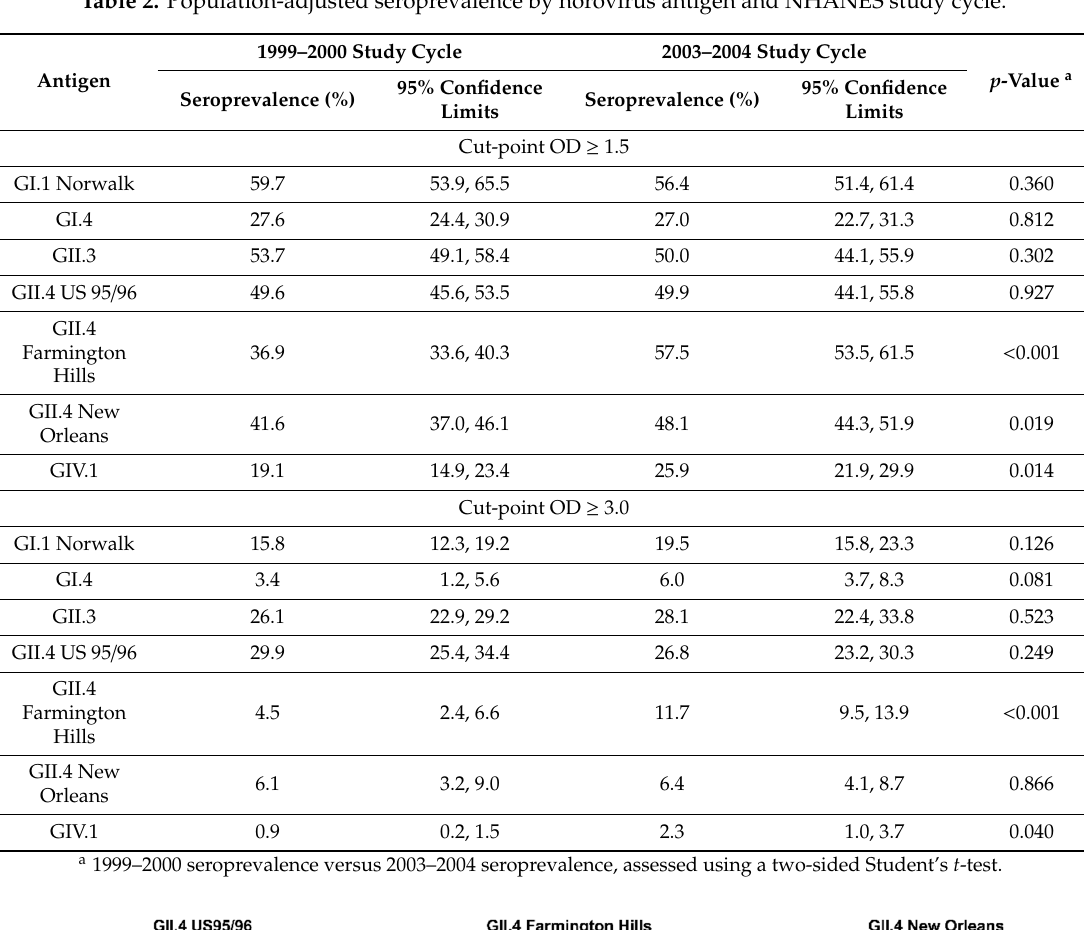
Table 2. Population-adjusted seroprevalence by norovirus antigen and NHANES study cycle.